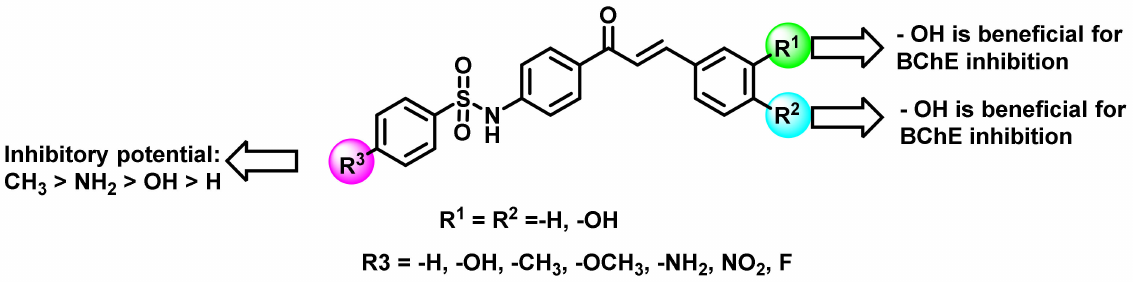
Figure 15. Chemical structures of chalcone sulphonamide derivatives.